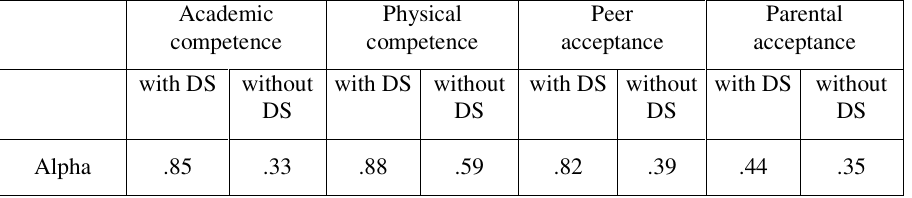
Coefficient Cronbach Alpha values for participants with and without Down